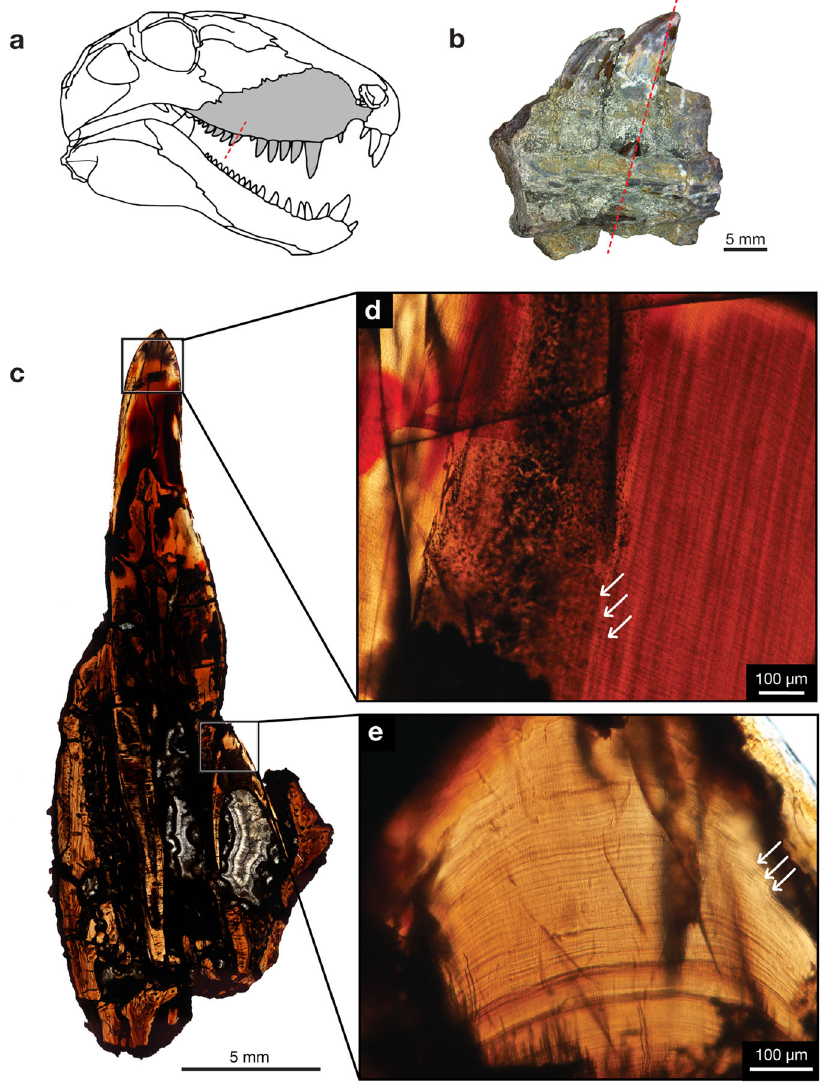
Fig. 3 | Incremental lines of Dimetrodon cf. D. limbatus . a Lateral view of Dime- trodon . b ROMVP 85510, maxillary tooth family, photographed in lingual view showing the plane of LL section through the functional tooth and replacement tooth. c Whole view of longitudinal LL section near the crown apex of functional